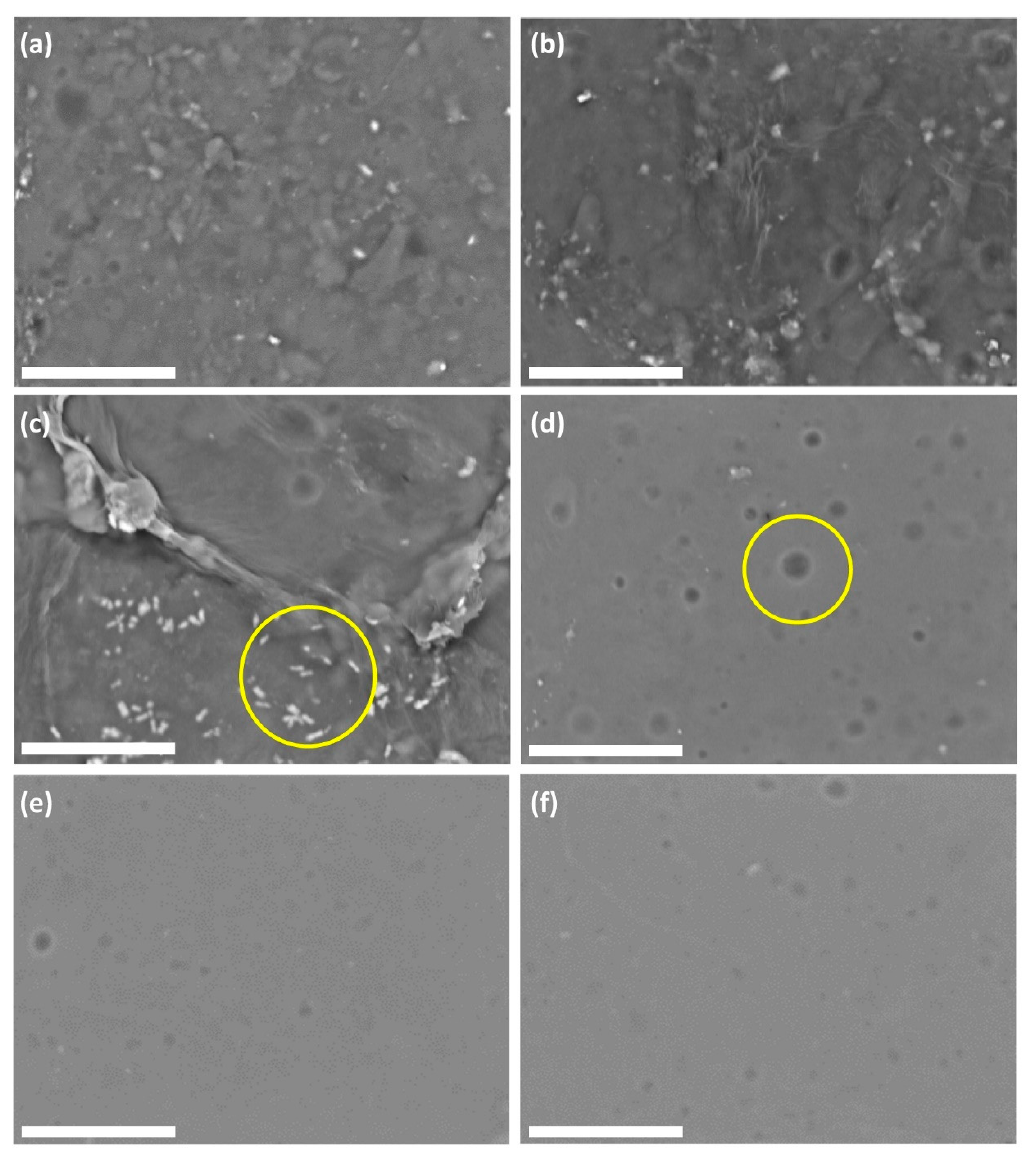
Figure 7. Scanning electron micrographs (2000 × ) of SRC reinforced with ( a ) 0%, ( b ) 3%, and ( c ) 7% (w/w) NCF, and RC films reinforced with ( d ) 0%, ( e ) 3%, and ( f ) 7% (w/w) NCF. The figure shows evidence of cellulose agglomeration (image (c)) and glycerol domains (image (d)). The images were obtained in backscattering mode using an accelerating voltage of 5 kV under a low vacuum. Scale bars represent 25 μ m.